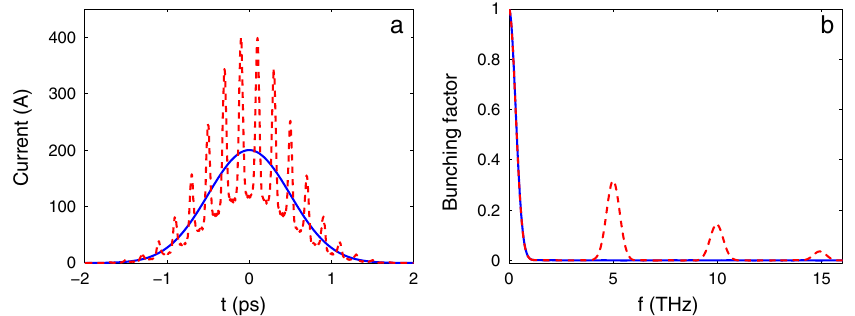
FIG. 5. (Color) (a) Initial current distribution (solid blue line) and that after the dispersion section (dashed red line). (b) Corresponding bunching factor for the initial current distribution (solid blue line) and that after the dispersion section (dashed red line).